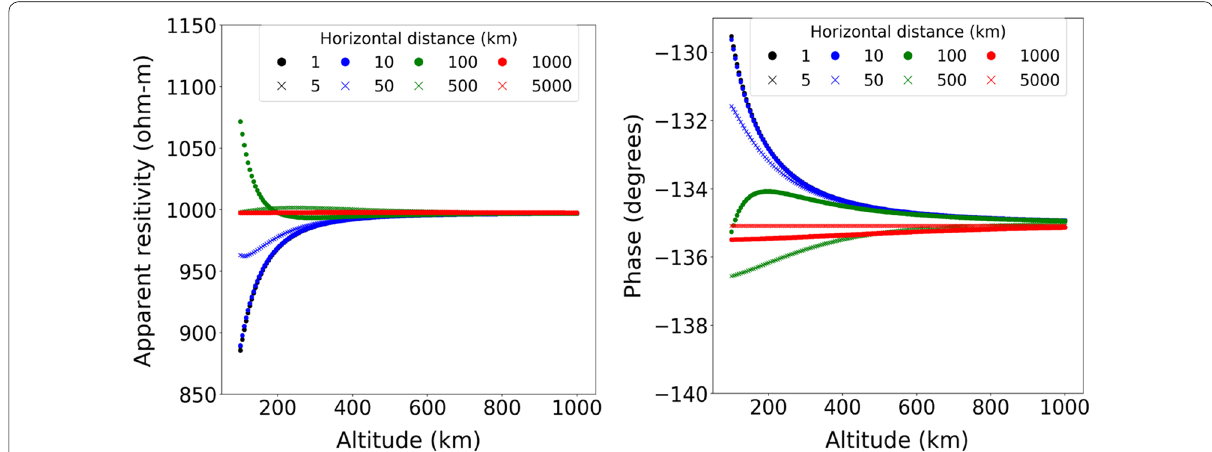
Fig. 2 MT responses at a period of 20 s: (left) relationship between the apparent resistivity and the altitude of the source current. (right) Relationship between the phase and the altitude of source current. The black/blue/green/red circles denote the responses derived from the horizontal distances of 1/10/100/1000 km, respectively. The black/blue/green/red crosses denote the responses derived from the horizontal distances of 5/50/500/5000 km,